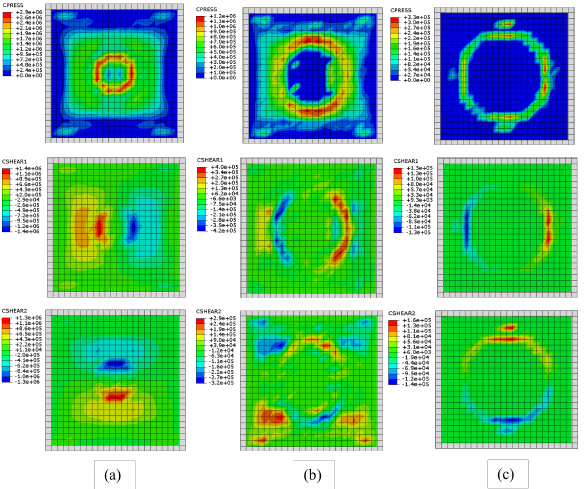
Figure 20: Distributions of normal contact (CPRESS) and shear contact (CSHEAR1, and CSHEAR2) of debonded model at instants of time a) t = 0.00045 s b) t = 0.00655 s c) t = 0.0358